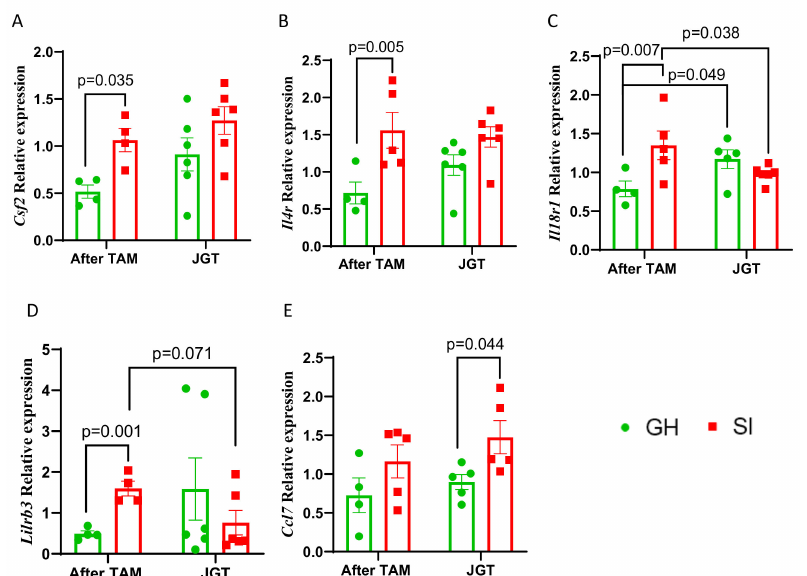
Figure 5. Effect of social isolation (SI) and Jaeumganghwa-tang (JGT) on genes related to inflammatory genes identified as differentially expressed by RNA sequencing analysis in the mammary glands after tamoxifen therapy ended. Expression of ( A ) Csf2 , ( B ) Il4r , ( C ) Il18r1 , ( D ) Lilrb3 , and ( E ) Ccl7 in the mammary glands of group-housed (GH) or SI rats after tamoxifen therapy, and either treated or not treated with JGT. SI significantly increased the expression of Csf2 , Il4r , Il18r1 , and Lilrb3 . JGT reverted the expression of Il18r1 and tended to inhibit Lilrb3 in SI rats. In GH rats, JGT had the opposite effect on the expression of Il18r1 than in the SI rats. Differences according to two-way ANOVA followed by the Holm–Sidak test. Means ± SEM, n = 4–7 per group are